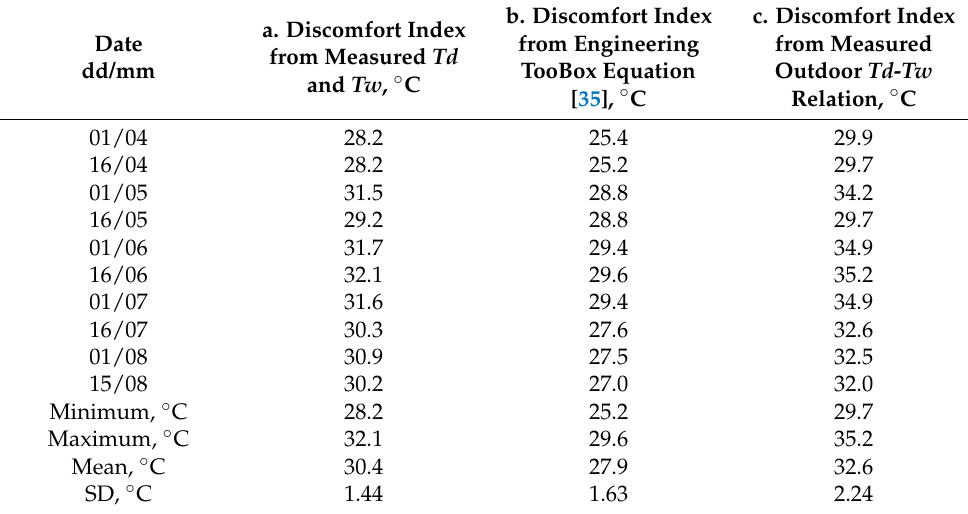
Table 2. Values of discomfort index calculated from measured indoor dry-bulb temperature ( Td ) and ( a ) measured indoor wet-bulb temperature ( Tw ), ( b ) indoor Tw calculated with Engineering ToolBox [35] equation (Figure 4a), and ( c ) indoor Tw calculated with measured outdoor Td - Tw relationship (Figure 4b).